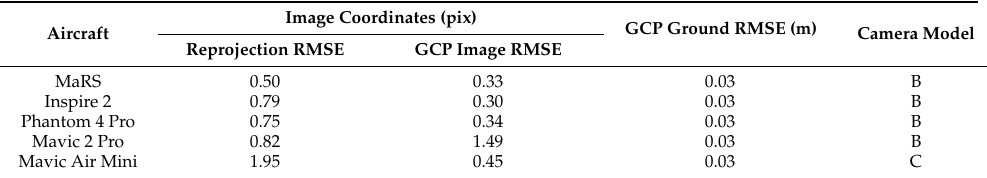
Table 5. Errors and camera models used when accessing ground control point (GCP) error and generating precision